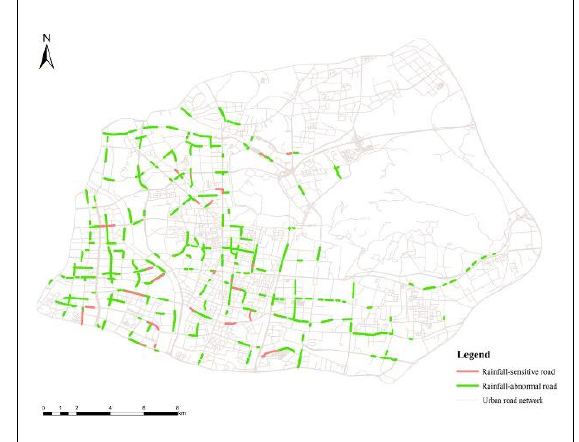
related to the distribution of rainfall-sensitive roads.